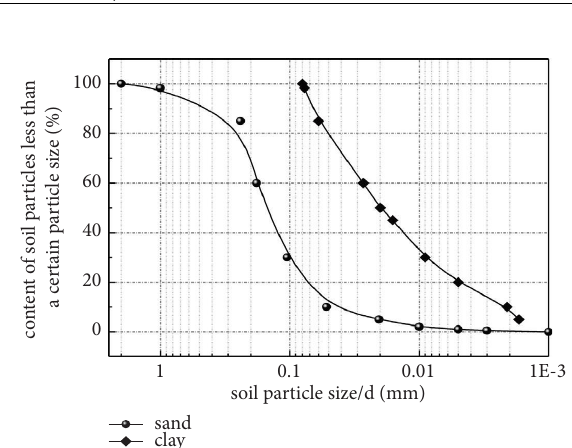
Figure 1: Grading curves for clay and sand used in the